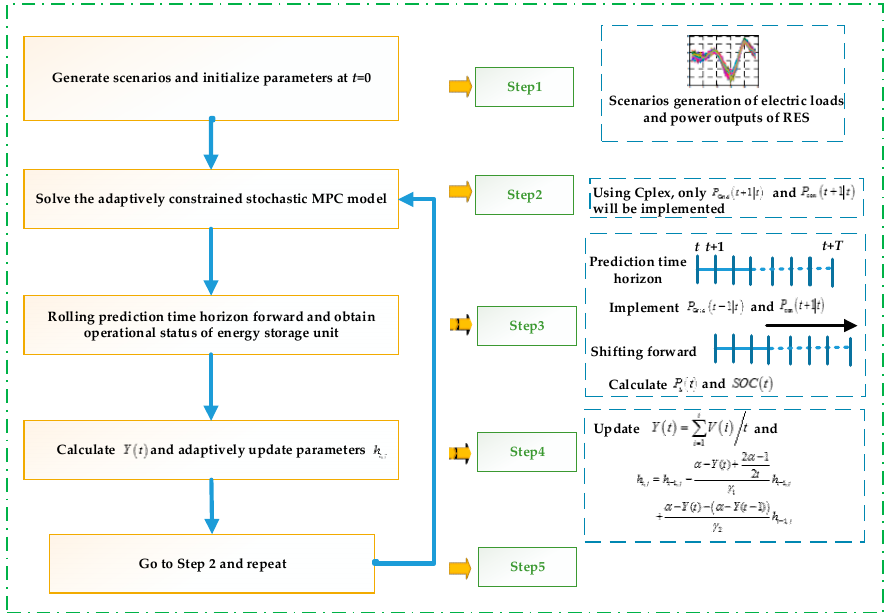
Figure 2. Procedure of solving adaptively constrained stochastic MPC for microgrid (MG) dispatch.